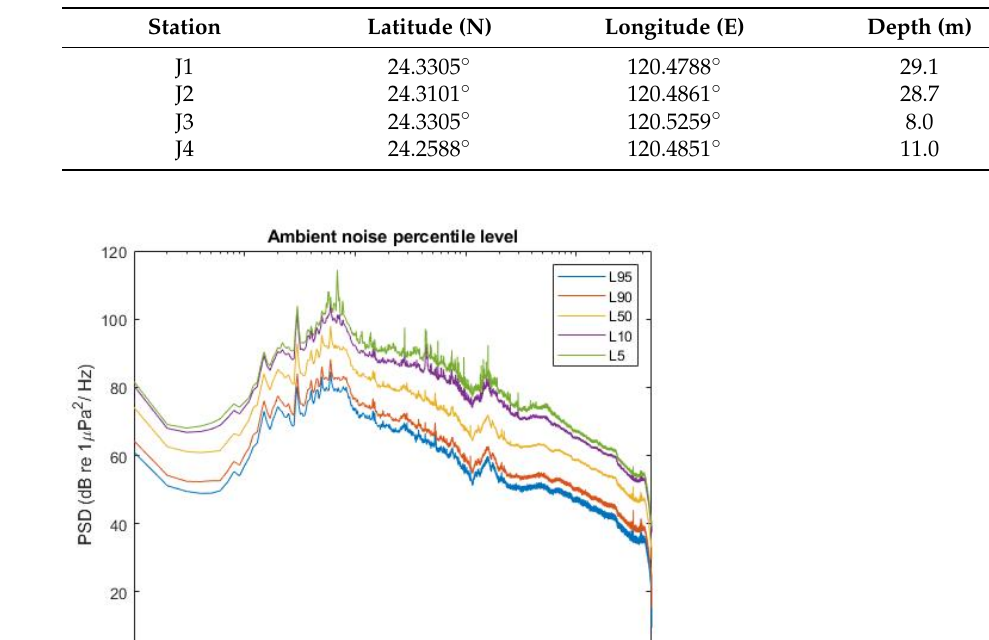
Table 1. Latitude and longitude of hydrophone stations.